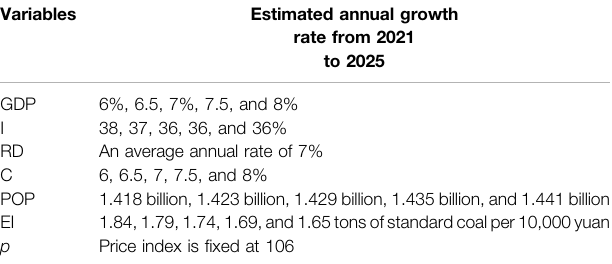
TABLE 5 | Indicators for the 14th Five-Year Plan period. Variables Estimated annual growth rate from